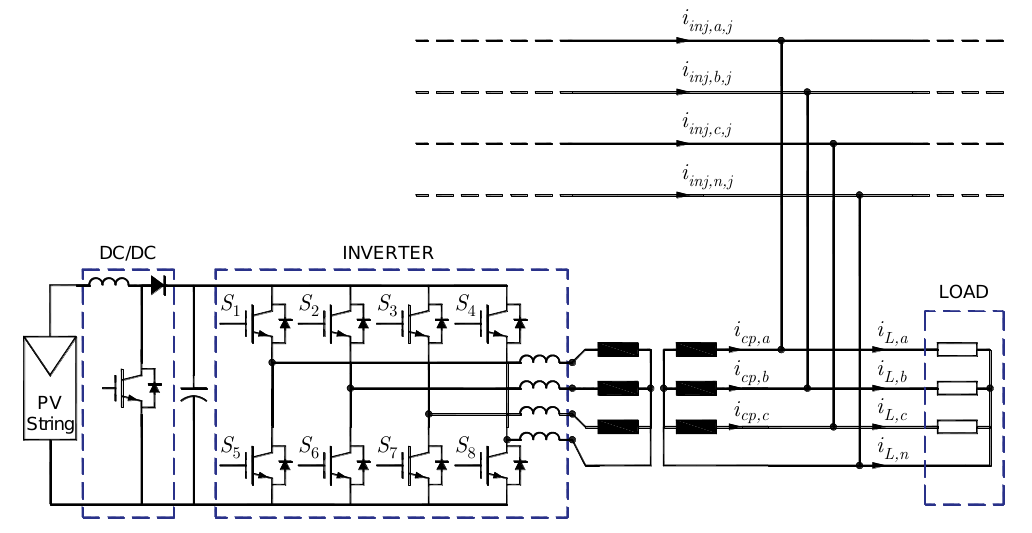
Figure 1 . PV system with four-leg power inverter. Figure 1. PV system with four-leg power